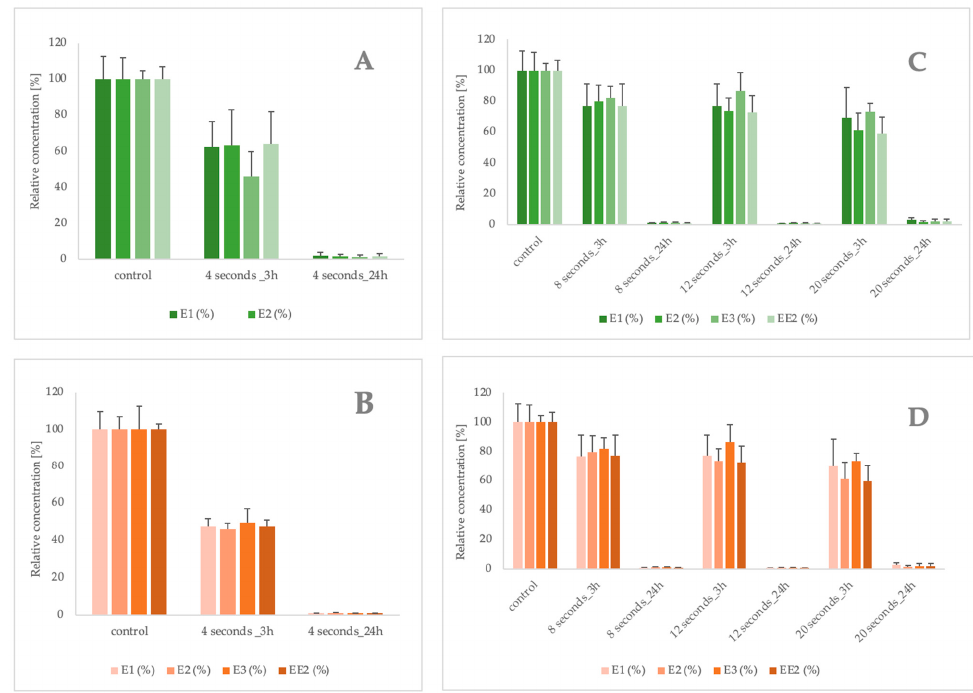
Figure 3. ( A ) Relative concentration of estrogens after treatment with persulfate (0.1 mM) activated by HC; ( B ) Relative concentration of estrogens after treatment with persulfate (0.1 mM) activated by HC combined with heat (60 °C); ( C ) Relative concentration of estrogens treated with persulfate (0.1 mM) activated by HC (8, 12, and 20 s treatment) analysed 3 and 24 h after reaction; ( D ) Relative concentration of estrogens treated with persulfate (0.1 mM) activated by the combination of HC (8, 12, and 20 s treatment) and heat (60 °C) analysed 3 and 24 h after the reaction. The second set of experiments was performed by combining heat and HC activation.